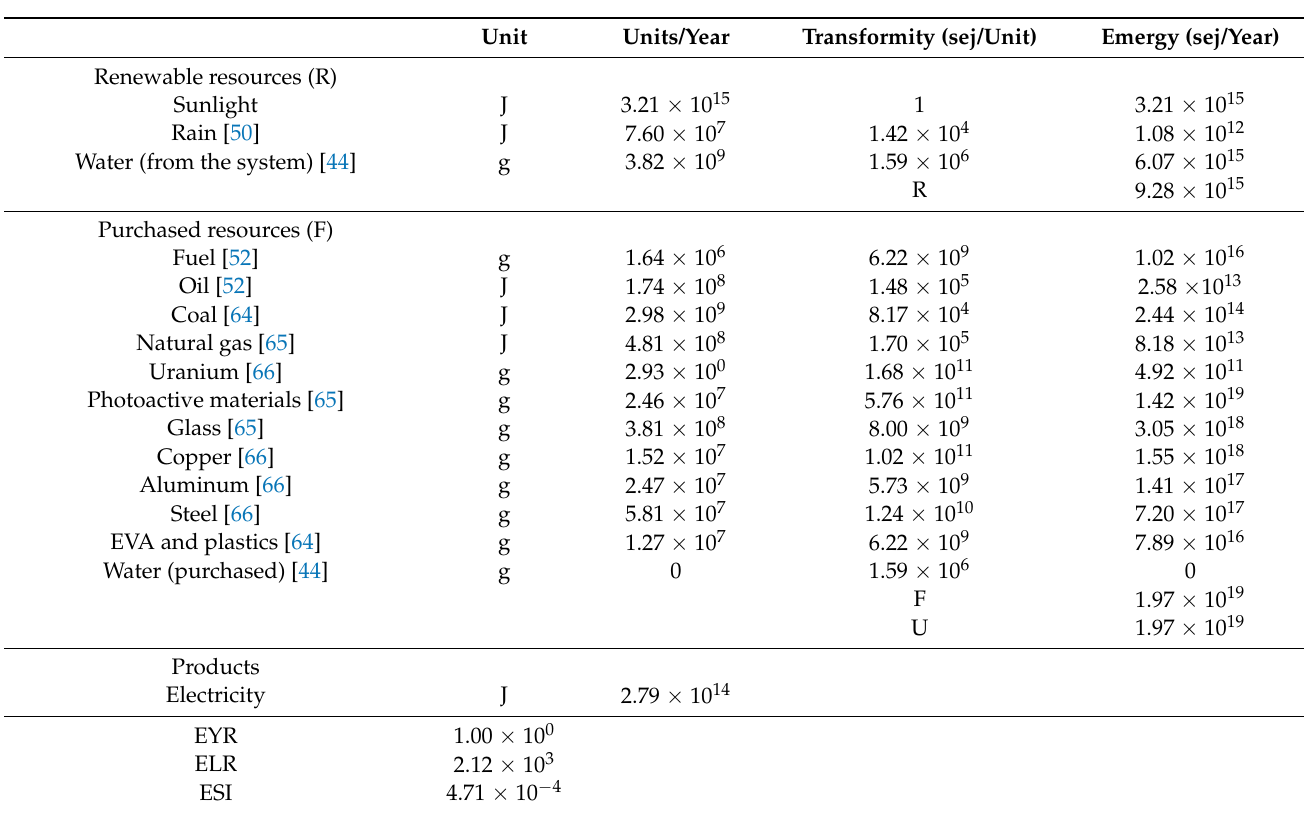
Table 10. Emergy calculation of solar power subsystem (after).